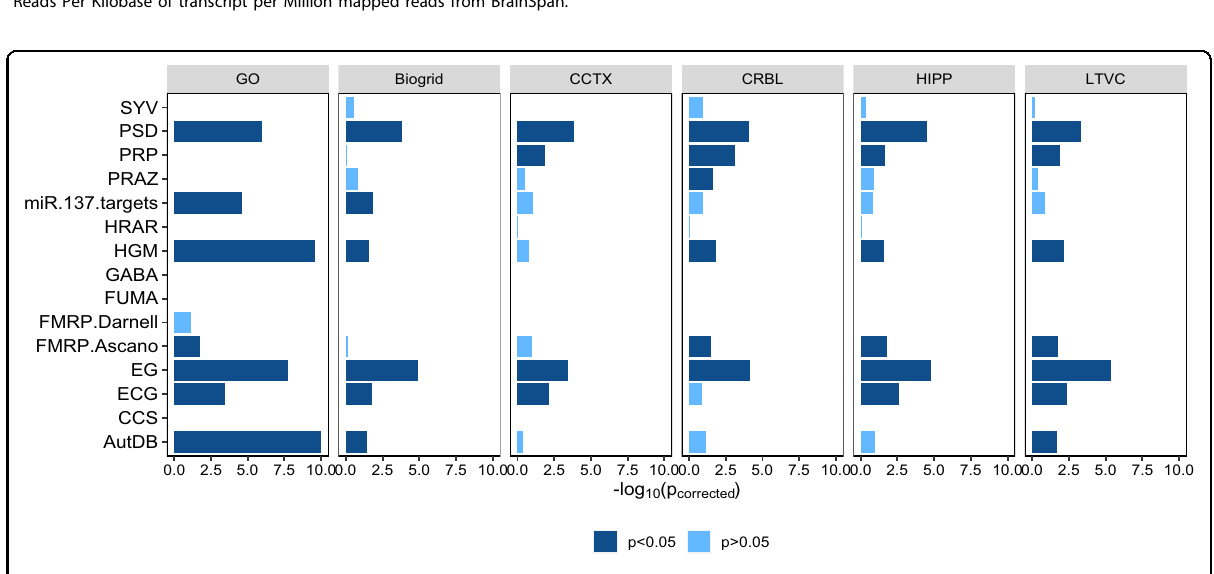
Distal regulatory elements obtained from CapHiC, FANTOM5, BrainCP, and BrainGZ databases. d Distance to index SNP. e Reads Per Kilobase of transcript per Million mapped reads from BrainSpan.